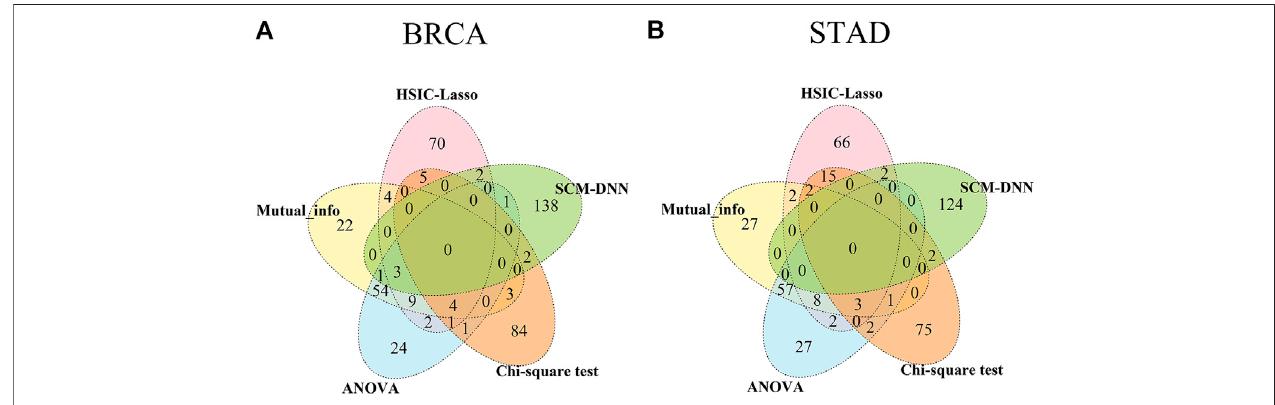
FIGURE4| Venndiagramforoverlapsamongtop100(network)featuresobtainedbySCM-DNN,HSIC-LASSO,ANOVA,Chi-squareandmutualinformationin (A) BRCA and (B)